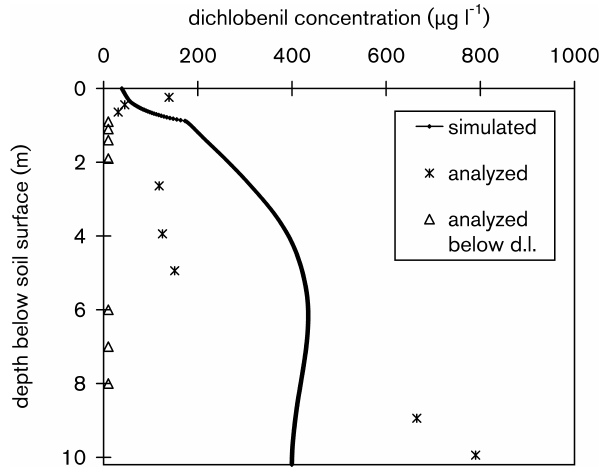
Fig. 8. Simulated and analyzed concentrations of dichlobenil at one identified hotspot (Fig. 2) in the vadose zone of the nursery field. The detection limit (d.l.) of the analyzed samples was about 10µgl − 1 . The date of calibration was 1 November 2003. The assumed application rate of dichlobenil was 1.7gm − 2 , applied at 24 times between 1976 and 1991.